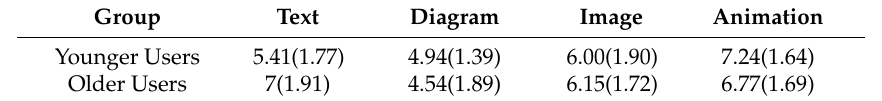
Table 15. Means and standard deviations for affective valence (standard deviation in parentheses, unit: points; nine-point Likert scale).